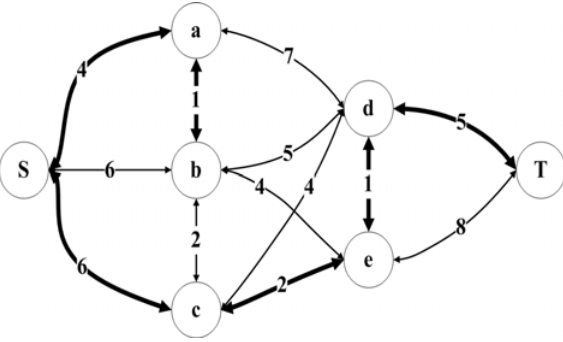
Figure 12. “Example of the shortest path